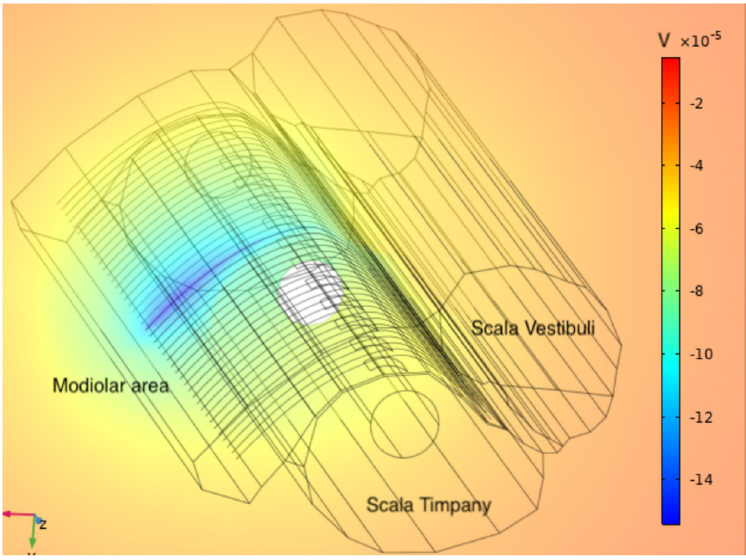
Fig 5. Potential. Representation of the potential generated by the VN placed in the central position at t = 0.4 ms.